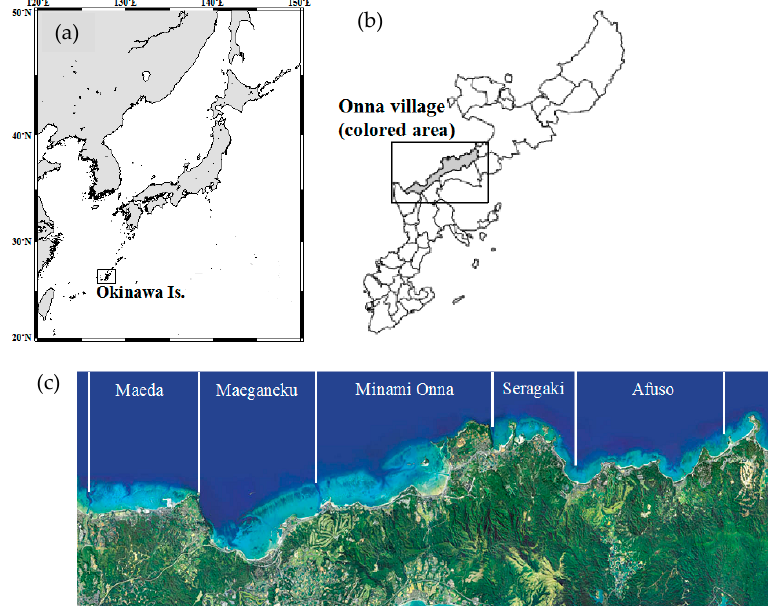
Figure 1. Study site maps: ( a ) Okinawa Island, Japan; ( b ) Onna Village on Okinawa Island; ( c ) five sectors, which are distinguished with channels, along the Onna